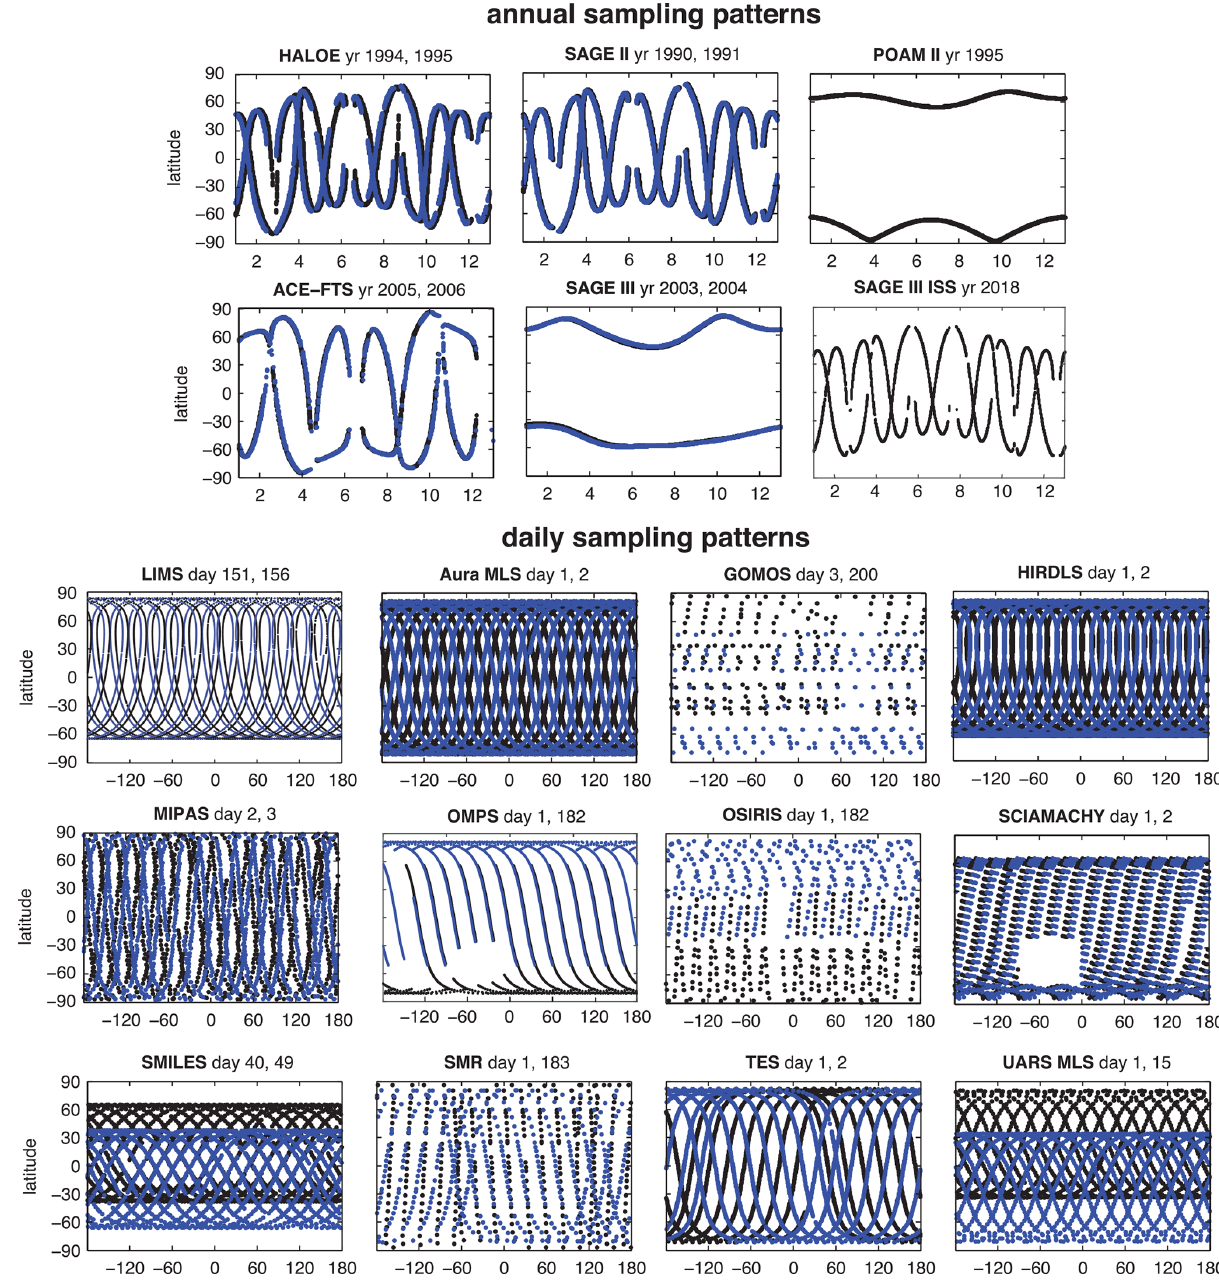
Figure 3. Representative sampling patterns for the instruments are shown in time–latitude space for solar occultation sounders to reflect annual sampling patterns (upper two rows) and in longitude–latitude space for emission/scattering and stellar occultation sounders to reflect daily sampling patterns (lower three rows). Different years or days are chosen to give a sense of change in the observed sampling patterns over time. See also Fig. 1 in Toohey et al. (2013) for the resulting measurement density in latitude–time space for the original SPARC Data Initiative instruments. Note that the sampling patterns of ACE-MAESTRO and POAM III are the same for ACE-FTS and POAM II, respectively, and thus are not shown here. The sampling pattern of SAGE I is very similar to that of SAGE II and HALOE. The gap in the sampling seen in OMPS and SCIAMACHY over South America is the result of the South Atlantic Anomaly, a dip in Earth’s magnetic field that allows charged particles to penetrate lower into the atmosphere and as a consequence causes irregularities in the recorded spectral signals by these